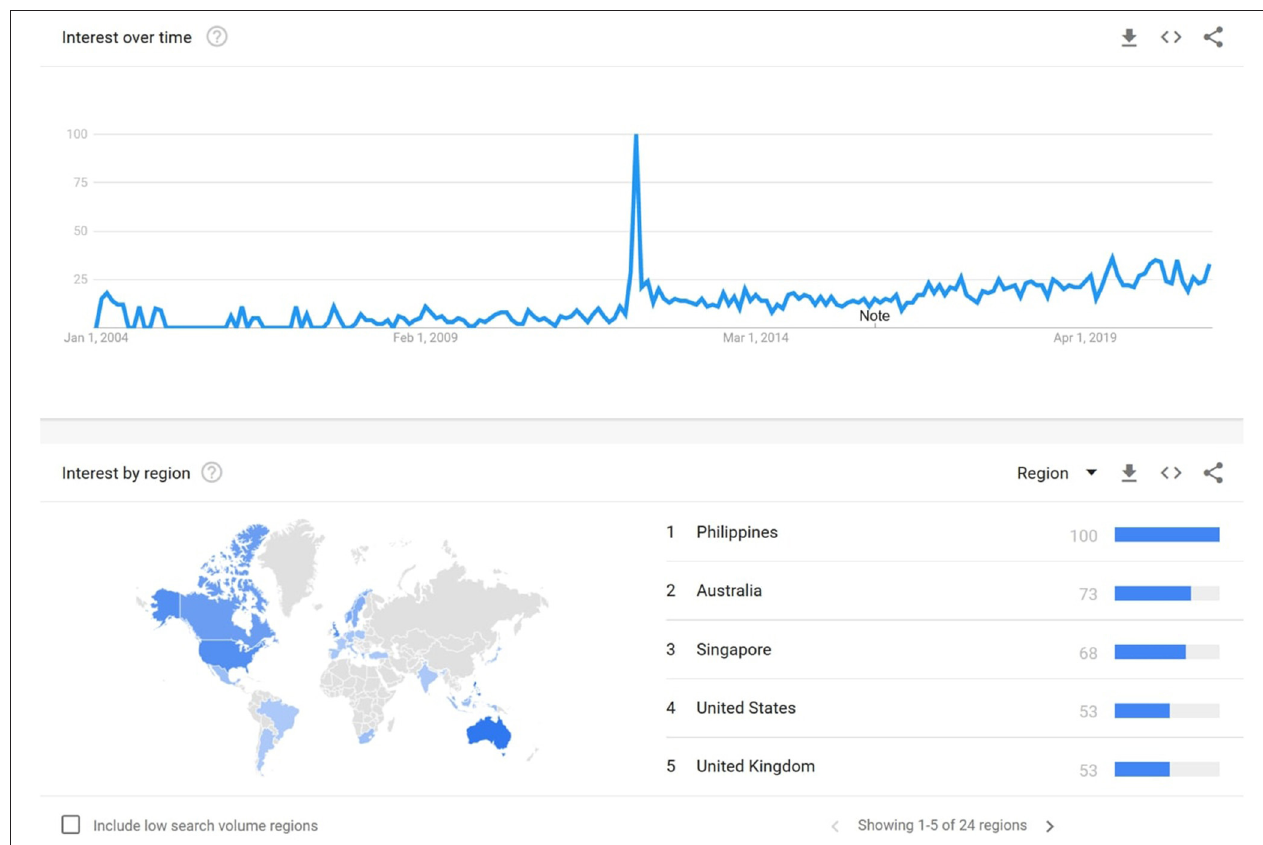
FIGURE 7 | “ Great Wave off Kanagawa ” search activity since 2004 (Google Trends,